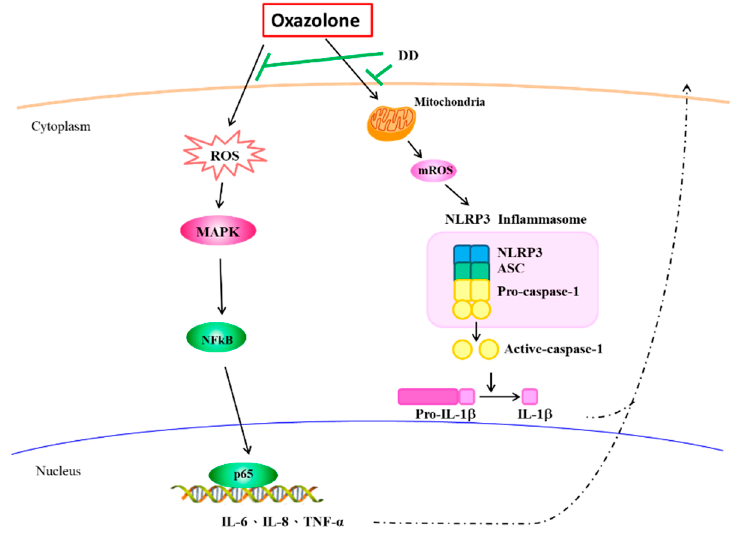
Figure 5. Proposed mechanism by which D. dasycarpus abolishes oxazolone-stimulated cytokines production, as well as diminishes NLRP3 inflammasome activation in HaCaT cells.